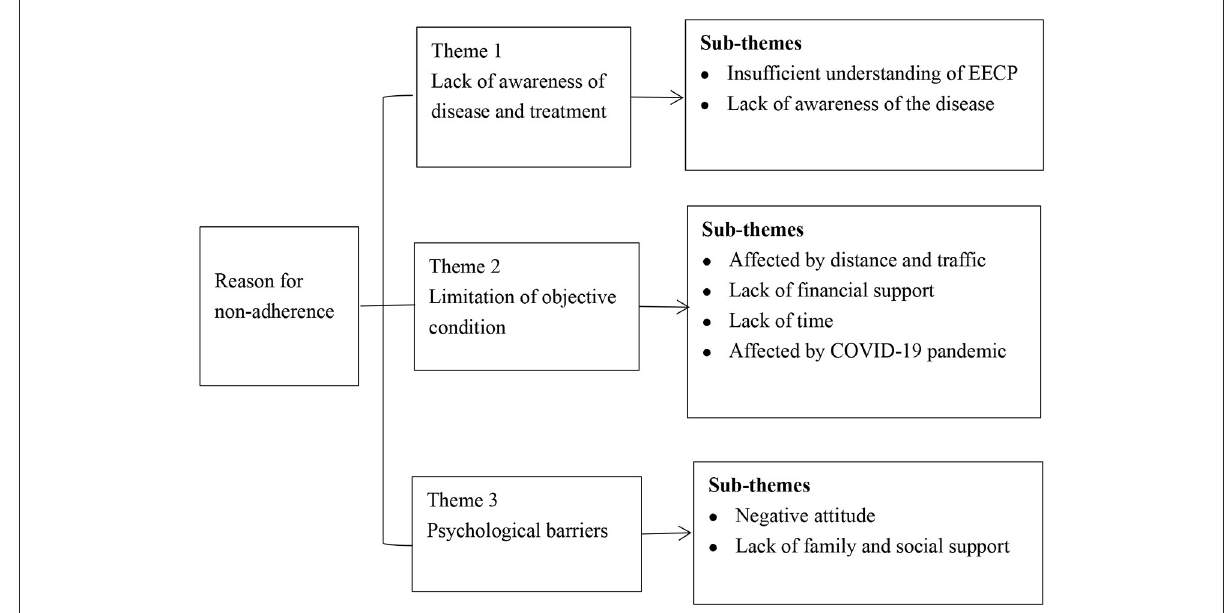
FIGURE1 Diagrammatic of the themes and subthemes within the thematic framework.